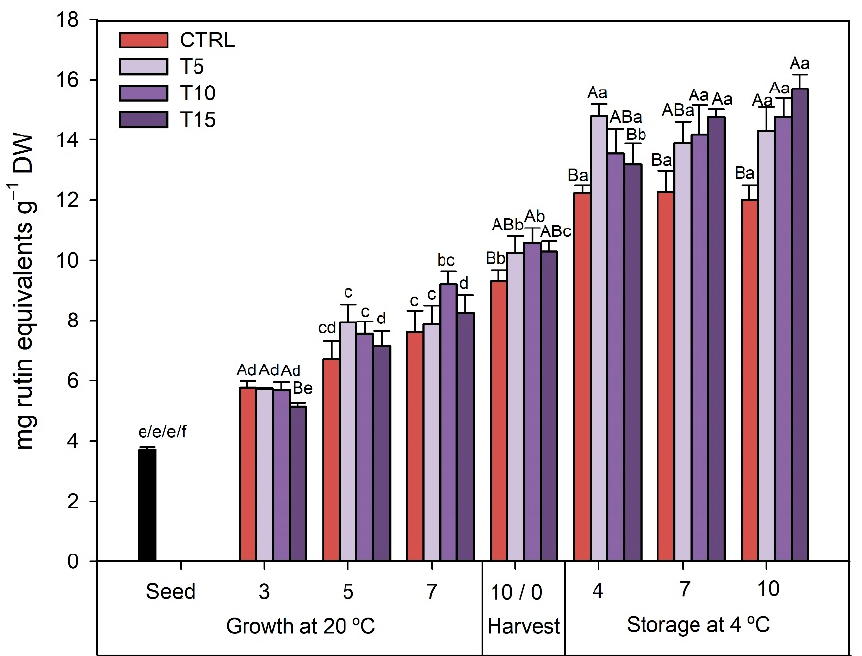
Figure 4. Total flavonoid content of control (0, CTRL) or UV-B treated (5, 10, and 15 kJ m − 2 ) red cabbage sprouts after 10 days growth at 20 °C and stored 10 days at 4 °C after harvest. Different capital letters indicate significant differences among treatments at p < 0.05 according to Tukey’s test ( n = 6, which were the plates collected, and each plate is a repetition). Different lowercase letters indicate significant differences among time of analysis of the same treatment at p < 0.05 according to Tukey’s test.